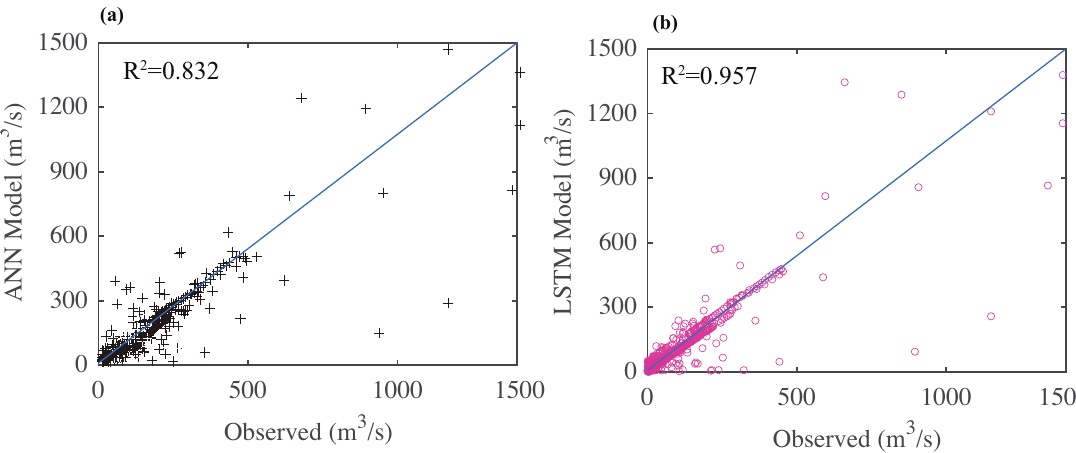
Figure 7. Scatter plot of the observed and the simulated runoff during 12 validation flood events. ( a ) ANN model; ( b ) LSTM